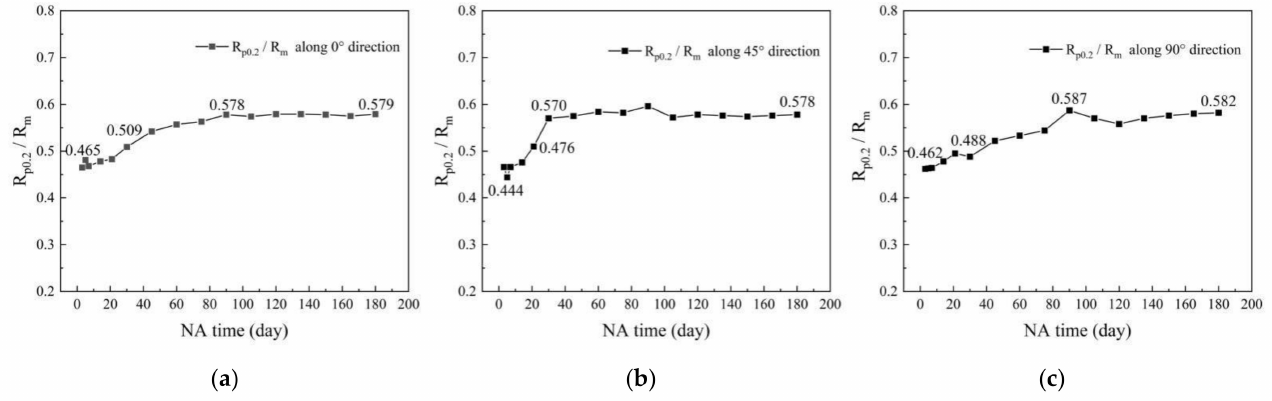
Figure 7. The change curves of R p0.2 /R m along 0 ◦ ( a ), 45 ◦ ( b ), and 90 ◦ ( c ) directions during six months of